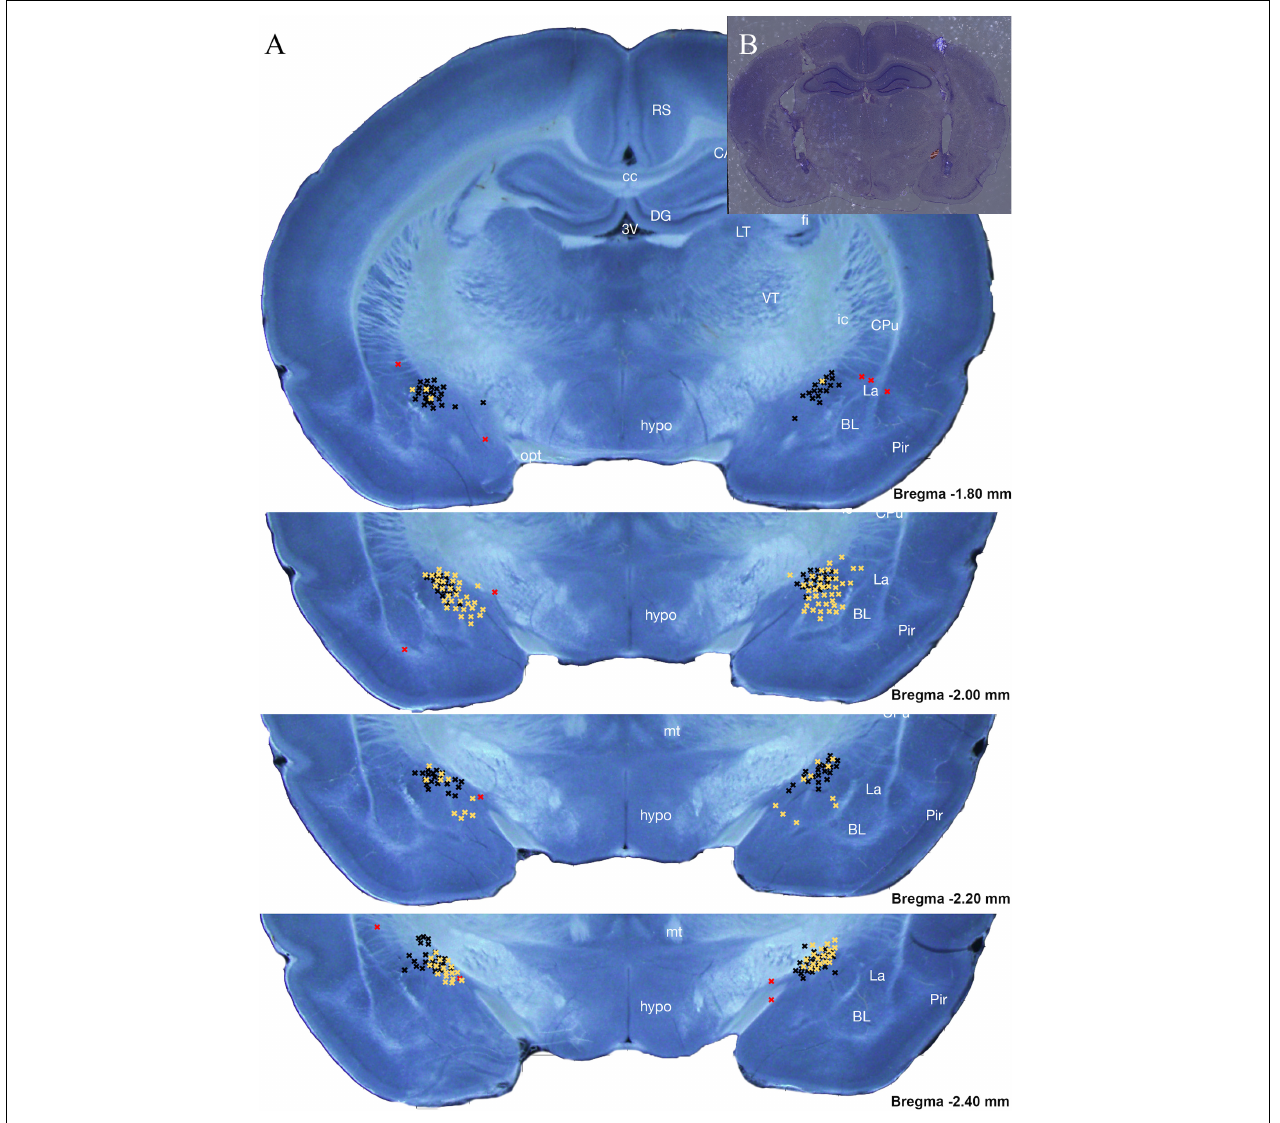
FIGURE 2 | Intracranial cannula placement diagram (A) and an example section (B) of histological analysis for subjects within Experiments 1 (black) and 2 (yellow) placement location of Antalarmin, Astressin 2B, or Vehicle infusion into the CeA. A total of 228 subjects were analyzed with only 18 from Experiments 1 and 5 from Experiment 2 determined to be misses. Each guide cannula “hit” viewed ended at one of the black X’s seen on the stitched atlas image between –1.80 and –2.40 mm away from Bregma. Any X’s categorized as “misses” are seen in red and ended at a point outside of this region of interest depicted (Bregma –1.80 to –2.40 mm). Misses were excluded from data analysis. A miss was categorized as > 1 mm away from the CeA. Neonatal brain images courtesy of Khazipov et al.